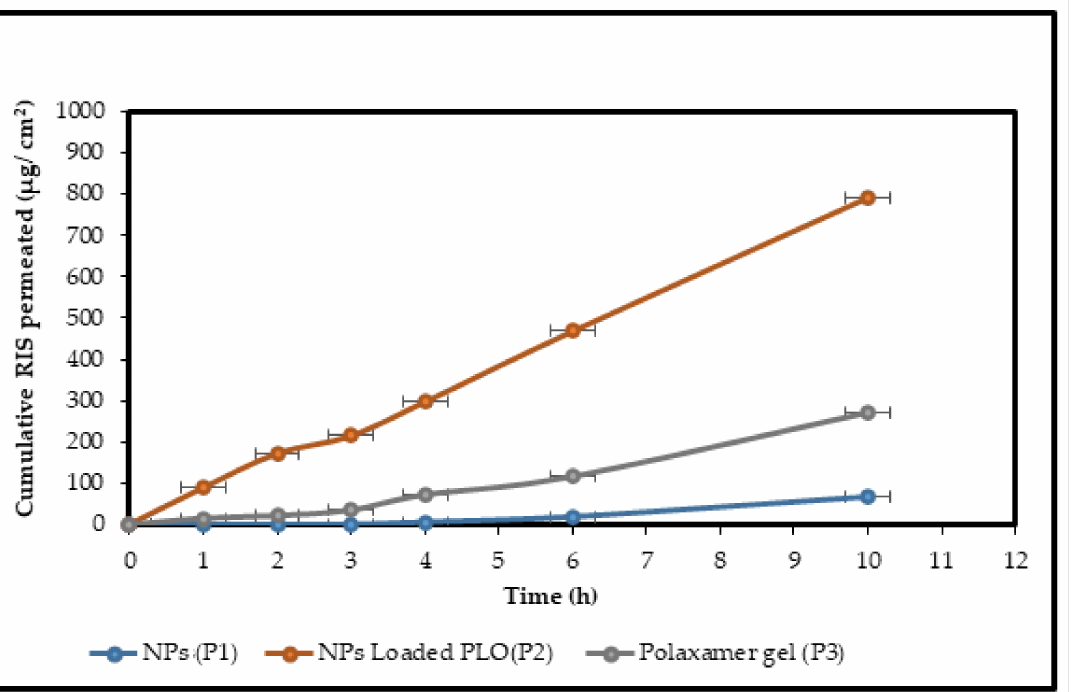
Figure 9. Graph represents the cumulative amount of RIS permeated across rat skin in the cases of NPs (P1), NP-loaded PLO (P2) and P gel (P3). Mean ± S.D. ( n = 3). Table 3. Ex vivo permeation studies for NPs, NP-loaded PLO and PL407 gel. Formulation